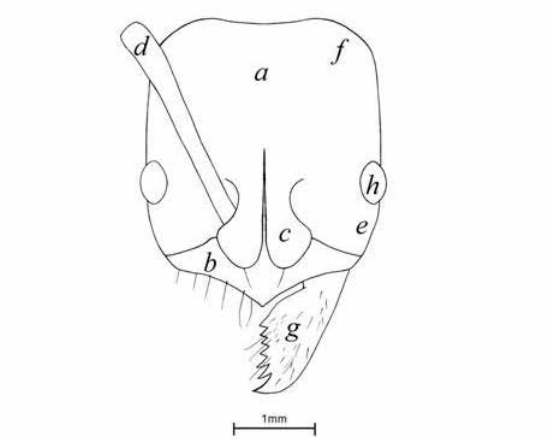
Fig 1 . The full view of the head of an African Bothroponera . a , frons; b , clypeus; c , frontal lobe; d , scape; e , malar space; f , posterior lateral corner of the head; g , mandible; h ,